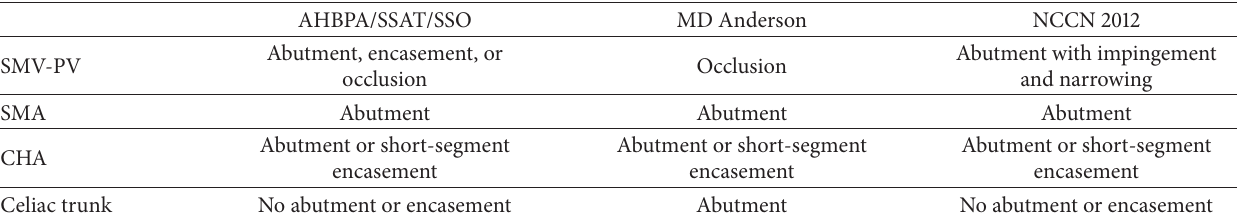
Table 1: Comparison of definitions of borderline resectable pancreatic